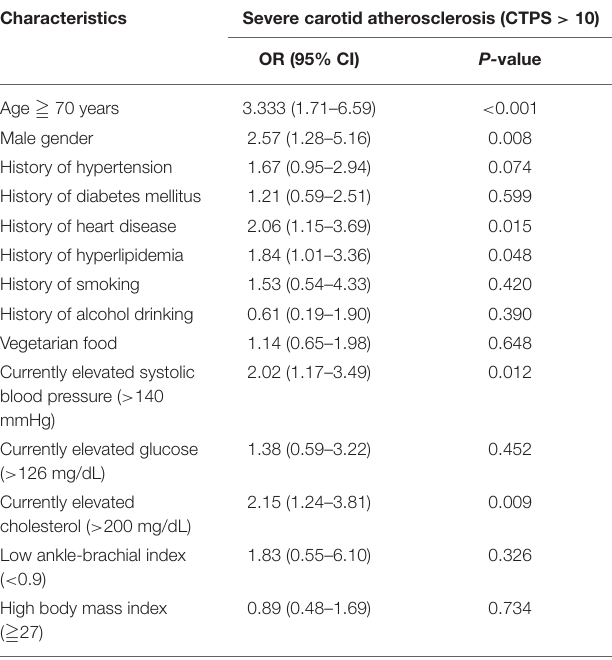
TABLE 5 | Logistic regression of factors influencing severe carotid atherosclerosis in 985 volunteers.